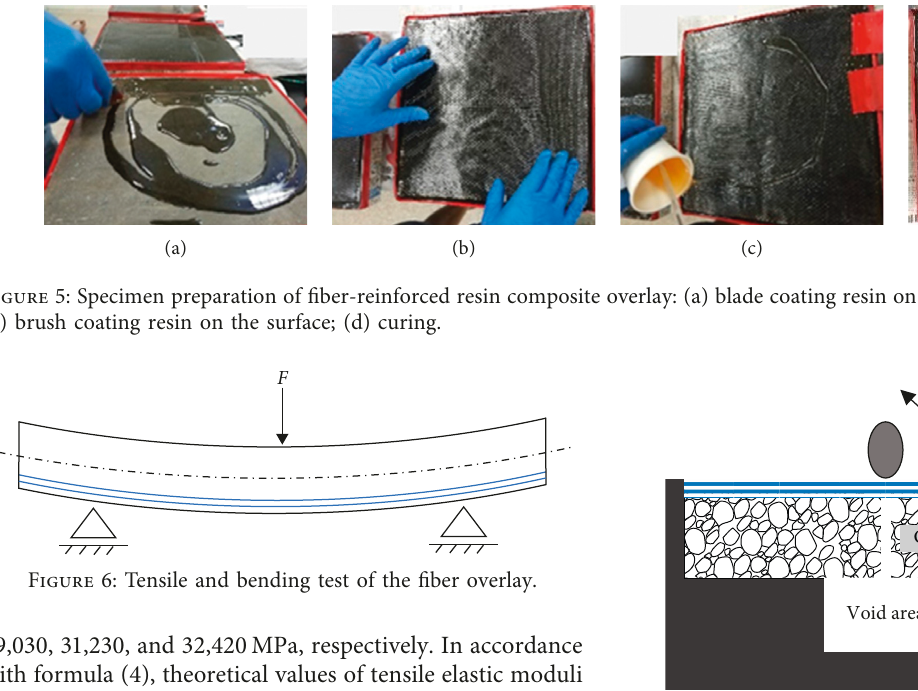
Figure 7: Schematic diagram of fatigue test on plates based on